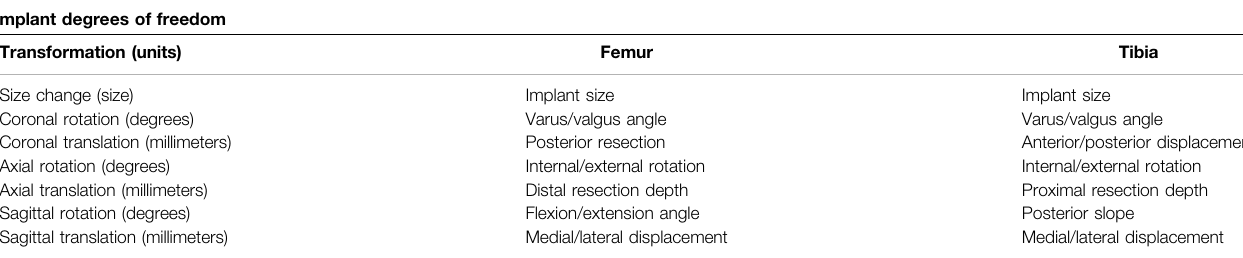
TABLE 1 | The seven transformations for the femoral and tibial implants, resulting in 14 degrees of freedom. Implant degrees of